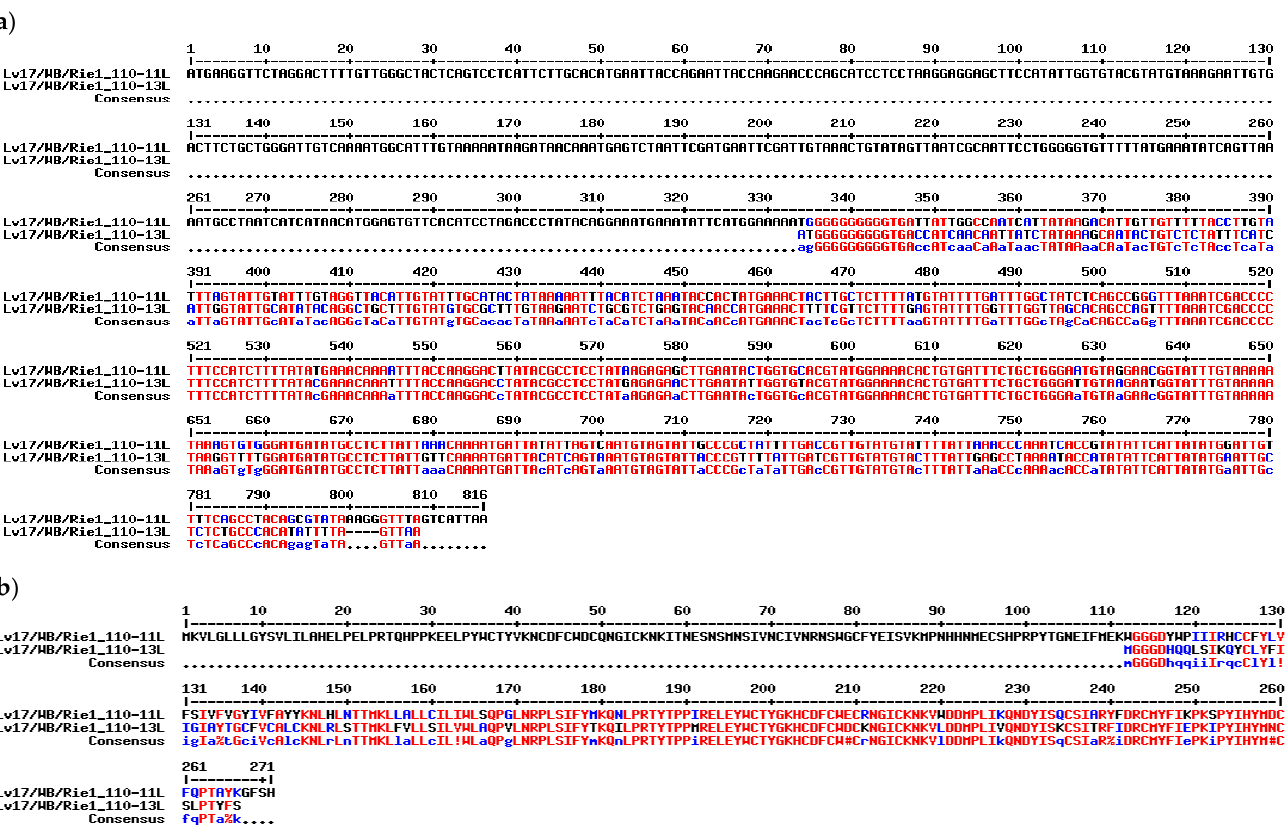
Figure 2. Nucleotide ( a ) and amino acid ( b ) differences between MGF 110-11L and MGF 110-13L of Lv17/WB/Rie1. Alignments were performed using the Multalin interface [38]. Table 4. G number variance in the G/C stretch of the MGF 110-11L gene of different African swine fever virus (ASFV) isolates. All sequences were collected from GenBank using nucleotide BLAST [39]. MGF 110-11L Gene Length of the Homopolymer G Region